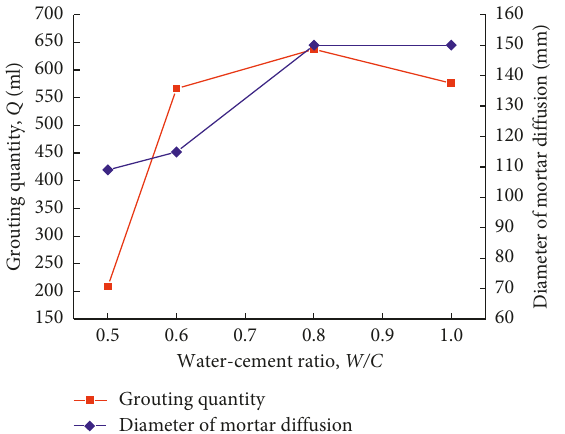
Figure 19: Characteristics of slurry diffusion ( P � 0.34MPa, k 2 � 0.13cm/s).